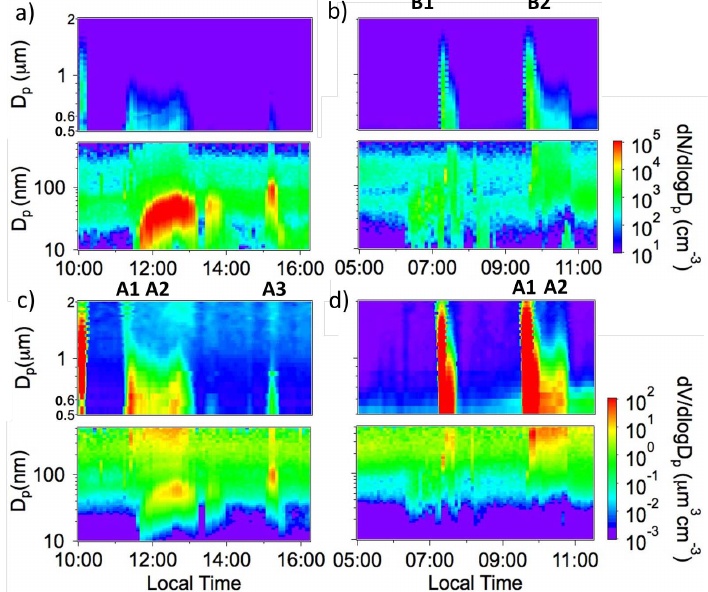
Fig. 5. Number (a, b) and volume (c, d) size distributions (SEMS and APS/OPS) of the plume particles on 17 July (a, c) and 18 July (b, d) . A particle formation and growth event is observed on 17 July, which contributes substantial aerosol mass to the plume. Only large plume particles were detected on 18 July.